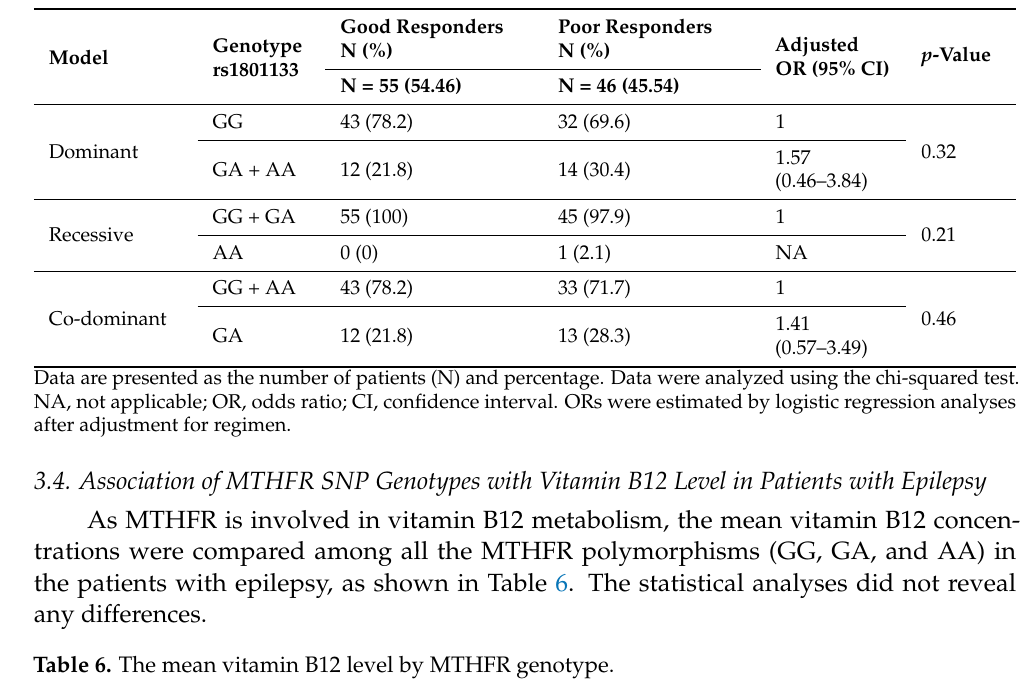
Table 5. Association between MTHFR polymorphism and patient’s response to ASMs.